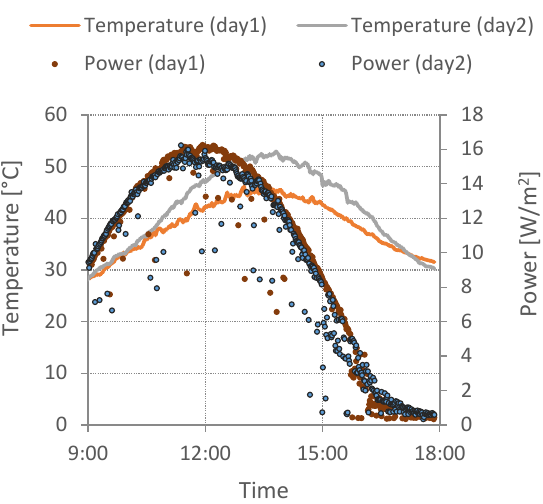
Figure 5. Measured power generated by PV and temperature on its backside.